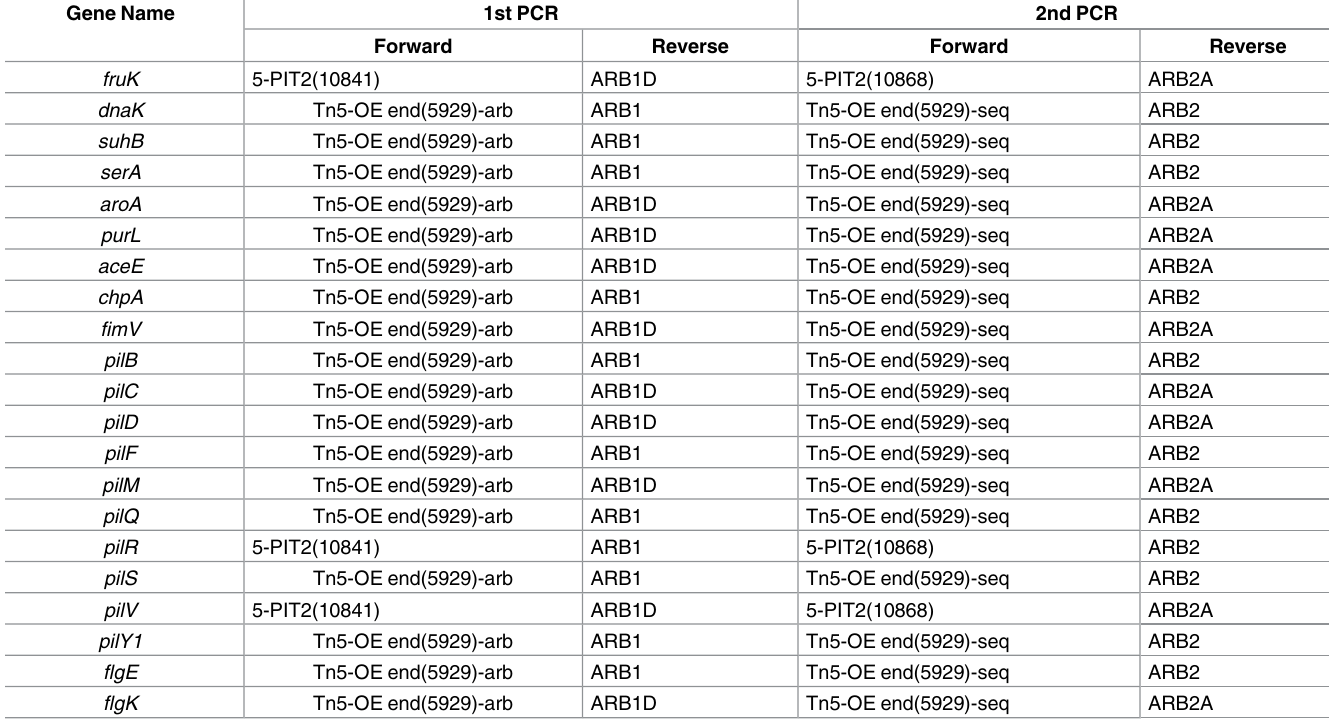
protocol [13,26] with a slight modification. The PCR primer sequences used for specification of the Tn5 insertion site are listed in Table 1, and a combination of forward and reverse prim- ers used for arbitrary PCR are shown in Table 2. A touchdown PCR was carried out, as previ- ously described [26]. In the first round of PCR, a primer (5-PIT2(10841) or Tn5-OE end (5929)-arb) specific to the transposon sequence was paired with a semi-degenerate primer with a defined tail (ARB1 or ARB1D). Total DNA from individual transposon insertion mutants was isolated from an overnight culture using the DNeasy Blood & Tissue Kit (QIA- GEN, Germany). For the first round of arbitrary PCR, PCR mix containing 1× GoTaq buffer Table 2. Arbitrary PCR primers used in this